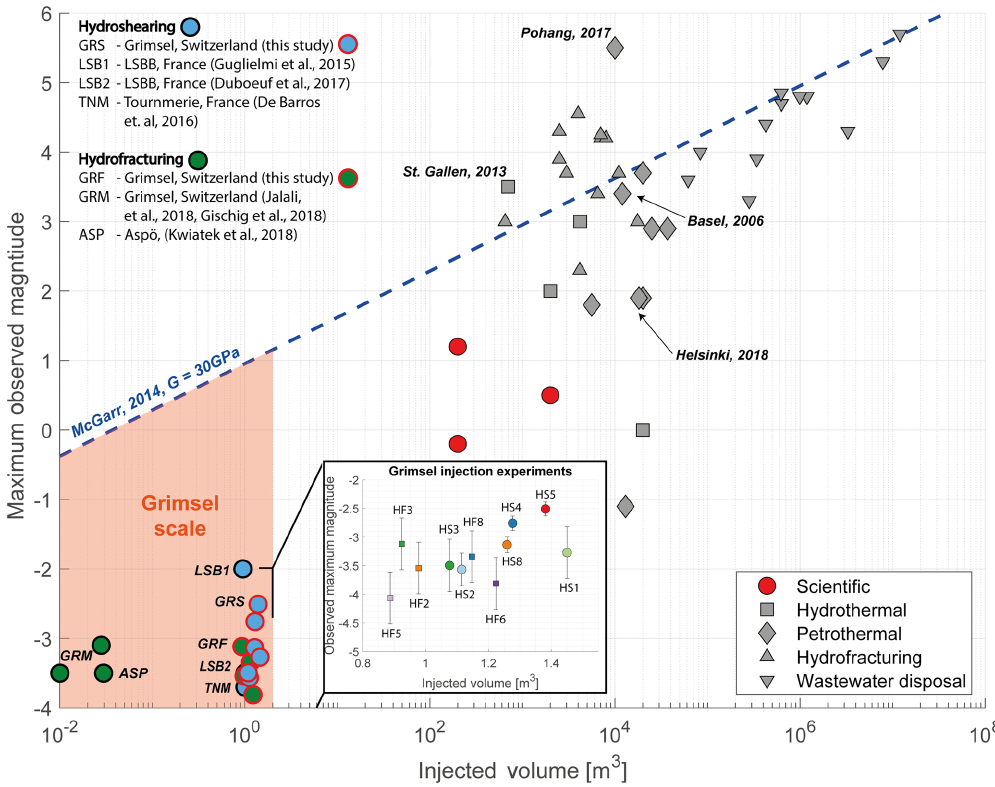
Figure 1. Injected fluid volume vs. maximum observed magnitude of fluid injections at different scales, along with McGarr (2014) estimate of the maximum observed seismic magnitude with respect to the injected volume. The detail box shows the maximum observed seismic magnitudes induced by the Grimsel injection experiments with respect to injected volume (error bars represent the standard deviation of all magnitude estimates of the respective seismic event). The magnitudes and injected volumes of larger-scale injections (>100m 3 ) directed towards hydrothermal (i.e., injection into aquifers), scientific, and petrothermal (i.e., injections into hot and dry rock volumes) purposes are adopted from Evans et al. (2012); injections directed towards waste water disposal are adapted from McGarr (2014); the projects directed to- wards hydrofracturing are adopted from Atkinson et al. (2016). Magnitude and injected volume data of the hydrothermal project in St. Gallen are from Obermann et al. (2015). Magnitudes and injected volumes for the petrothermal projects in Basel, Pohang, and Helsinki are from Häring et al. (2008), Grigoli et al. (2018), and Kwiatek et al. (2019),